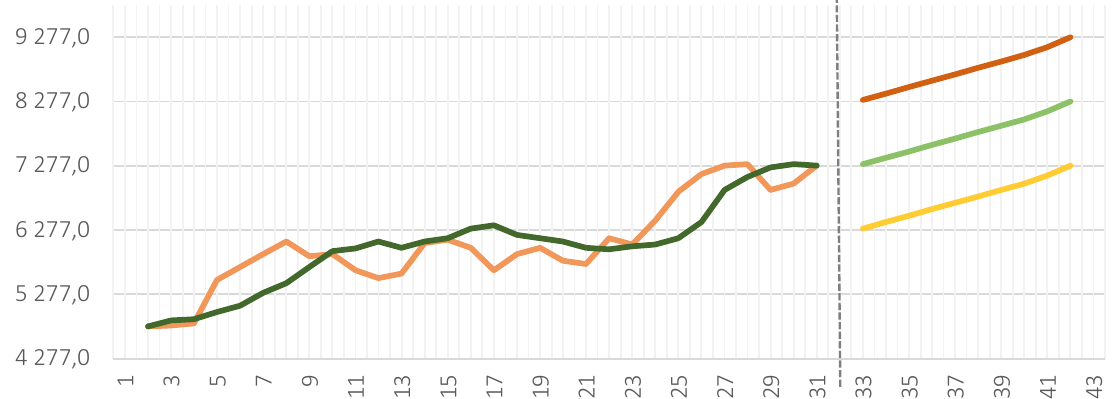
Figure 3. Exponential smoothing daily